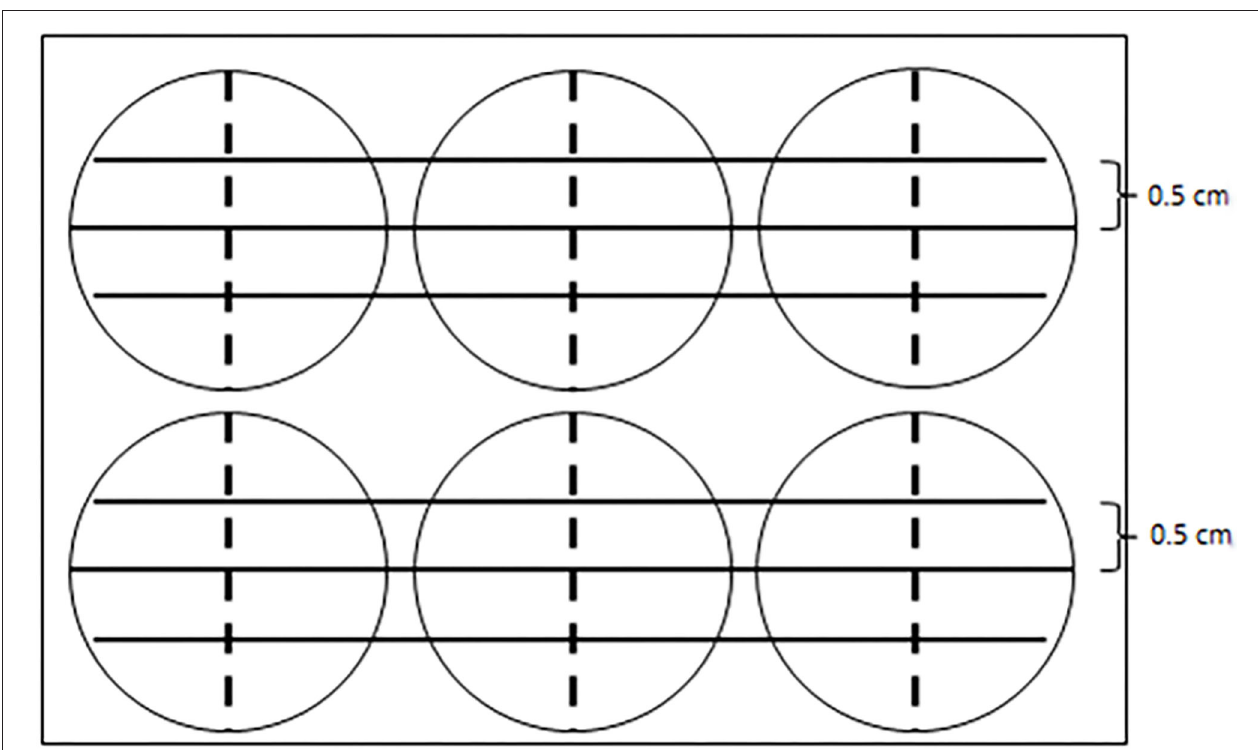
FIGURE 1 | A diagram showing the reference line in the cell scratch test. Three parallel solid lines were drawn by a marker pen on the back of a six-well plate. Each parallel line was 5cm apart. The tip of a 200- µ l sterilized pipette scratched along the dotted line, which was perpendicular to the solid lines and was along the diameter of each well.